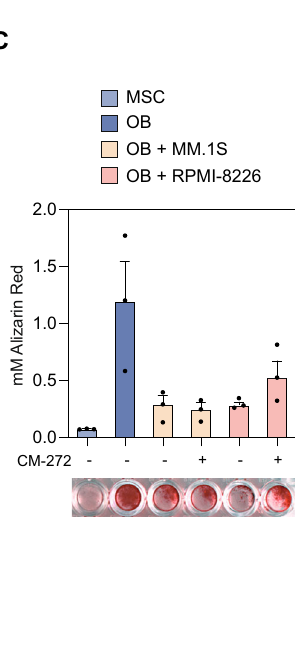
Quantitative real-time PCR (qRT-PCR) . Reverse transcription was performed using the Transcriptor First Strand cDNA Synthesis Kit (Roche) according to the manufacturer ’ s instructions. qRT-PCR was performed using LightCycler ® 480 II System with LightCycler ® 480 SYBR Green Mix and data were analyzed with LightCycler ® 480 II Software, version 1.5, all provided by Roche. Reactions were performed in triplicate for both the target and the housekeeping gene ribosomal